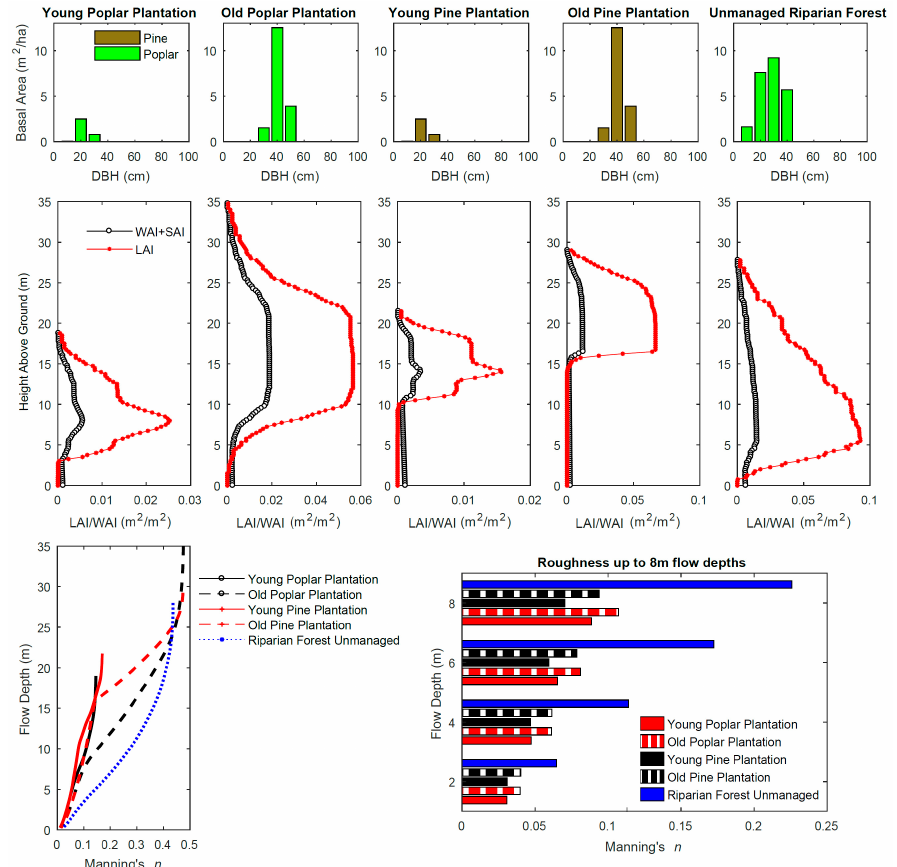
Figure 1. The basal area size distribution of the test Floodplain Forests considered in this study (top row); Young and Old Poplar Plantations, Young and Old Pine Plantations, and an Unmanaged Riparian Forest. The middle row shows the Wood and Stem Area Index (WAI + SAI) and Leaf Area Index (LAI) vertical profiles determined for the five forest types. The last row shows resulting Manning’s n roughness calculated from forest structure shown in the middle row. WAI = 0.172, 1.361, 0.079, 0.489, 0.917; and LAI = 0.736, 3.997, 0.385, 2.724, 5.306 for Young and Old Poplar Plantations, Young and Old Pine Plantations, and an Unmanaged Riparian Forest. Manning’s n is in units of s m − 1/3 .